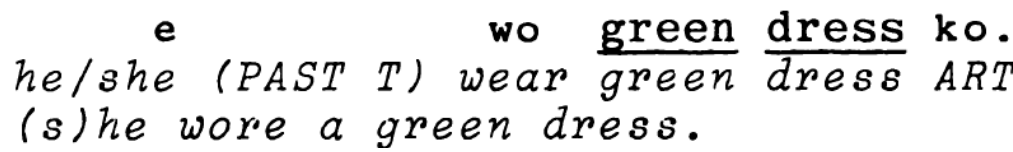
Figure 4. Evidence against the free morpheme constraint (from Nartey 1982, p. 185, example 3).